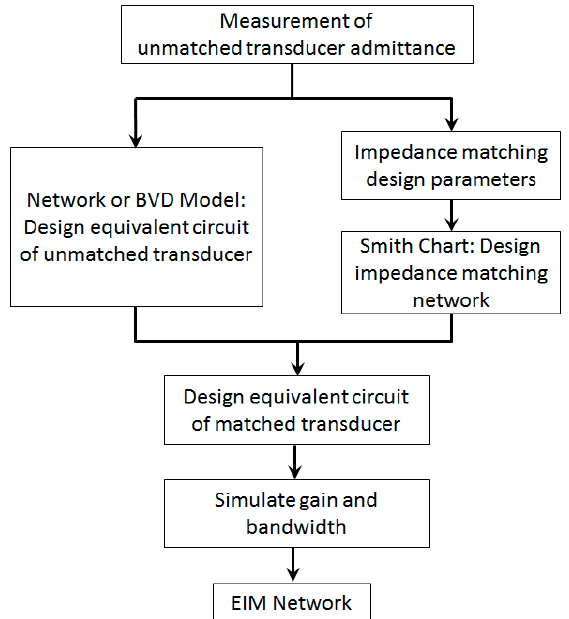
Figure 8. Block diagram representing an electric impedance matching network design process [27].